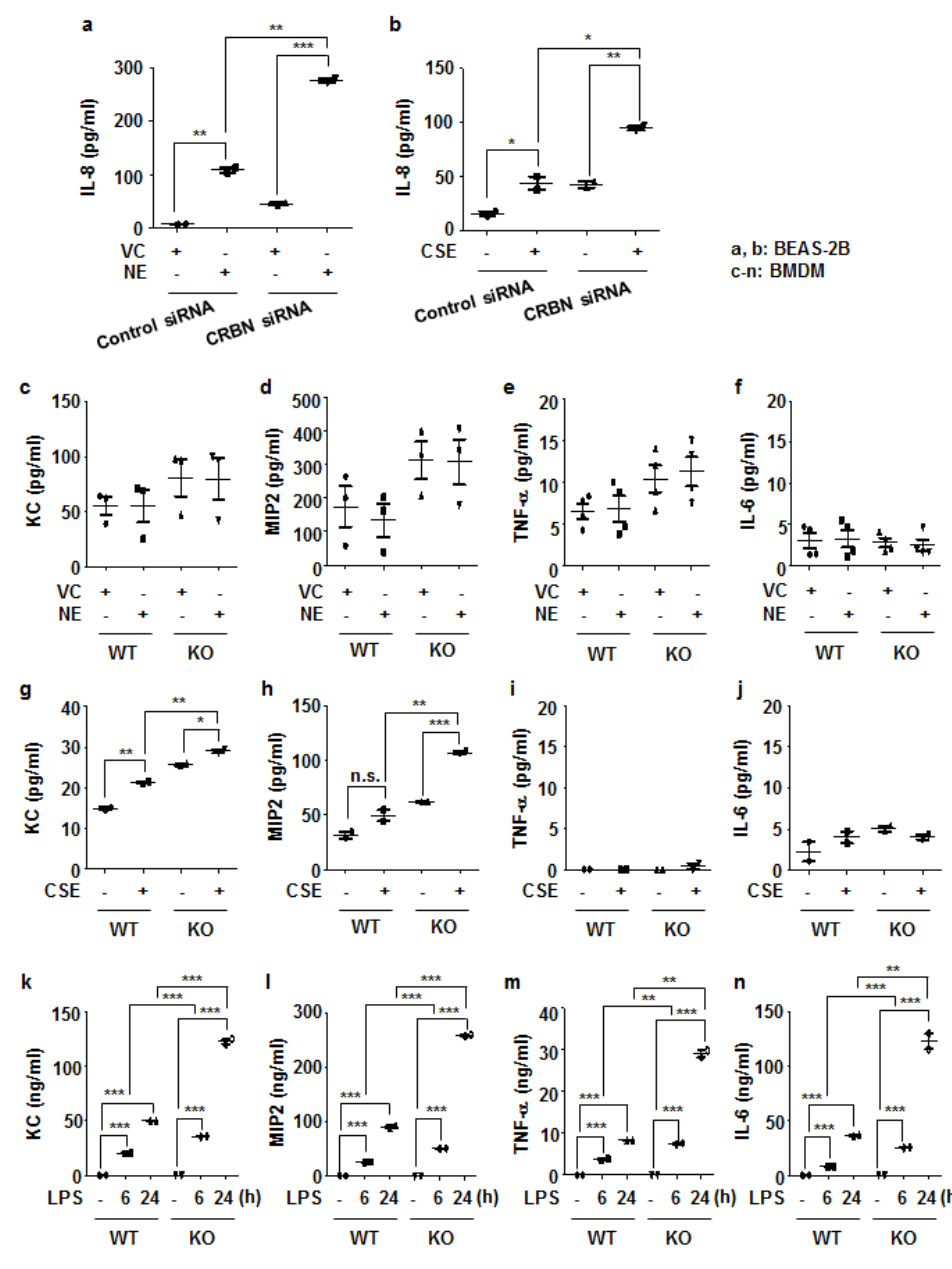
Figure 4. Crbn KO enhanced the production of inflammatory cytokines/chemokines in lung epithelial cells and macrophages. ( a , b ) BEAS-2B cells were transiently transfected with control siRNA or Crbn siRNA. Forty-eight hours after transfection, the cells were treated with VC or NE (1 U/mL) ( a ) and CSE (1%, v / v ) ( b ) for 24 h. The concentration of IL-8 in cell supernatants was measured with an ELISA. Data represent the mean ± SD. * p < 0.05, ** p < 0.01, and *** p < 0.001 ( c - f ) WT and Crbn KO BMDMs were treated with VC or NE (1 U/mL) for 24 h. ( g - j ) WT and Crbn KO BMDMs were treated with CSE (1%) for 24 h. ( k – n ) WT and Crbn KO BMDMs were treated with LPS (100 ng/mL) for 6 or 24 h. The levels of inflammatory cytokines/chemokines in cell culture media were measured with an ELISA. Data represent the mean ± SD. * p < 0.05, ** p < 0.01, and *** p <